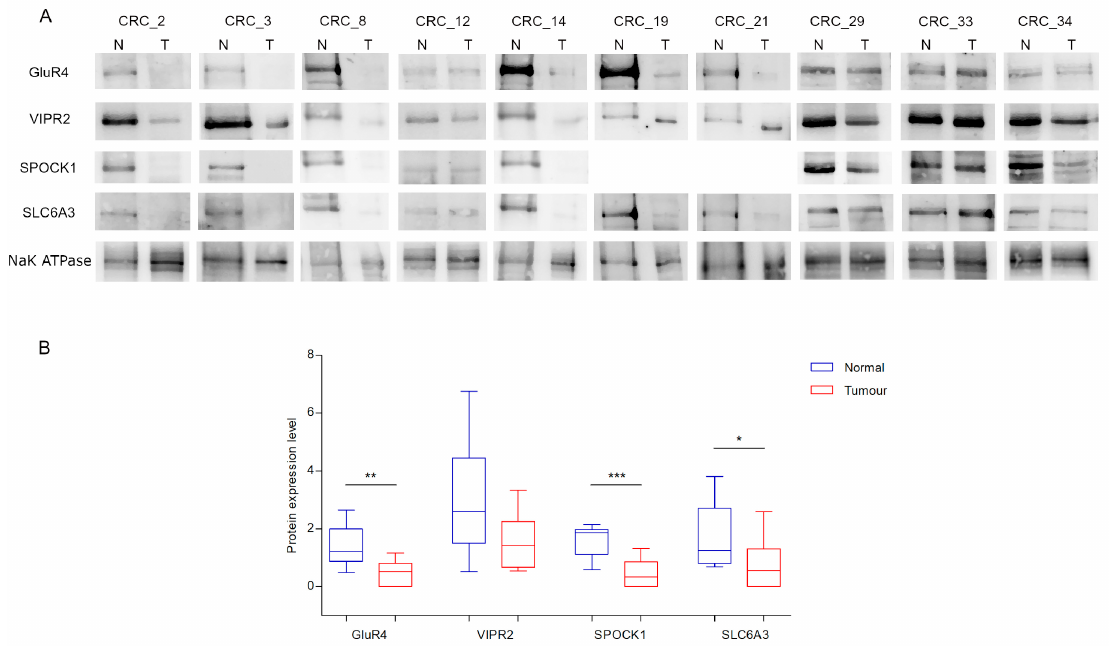
Figure 5. Protein expression level for each paired sample. ( A ) Representative blots of GluR4, VIPR2, SPOCK1 and SLC6A3 protein expression in 10 CRC paired tissues samples. NaK ATPase was used as loading control. ( B ) Box plots of GluR4, VIPR2, SPOCK1 and SLC6A3 expression. Asterisks indicate statistically significant di ff erences (* p value < 0.05, ** p value < 0.01, *** p value < 0.001). For the SPOCK1 expression study, there was not enough protein lysate for samples 19 and